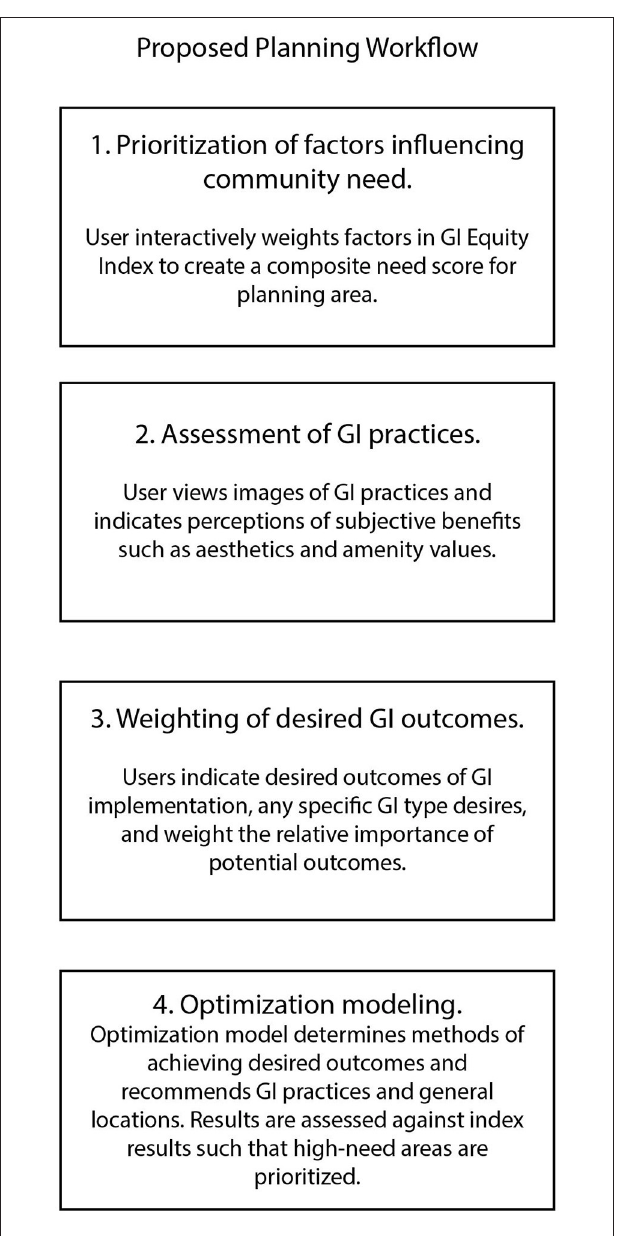
FIGURE 2 | Schematic of proposed planning tool incorporating equity index and additional planning concerns.